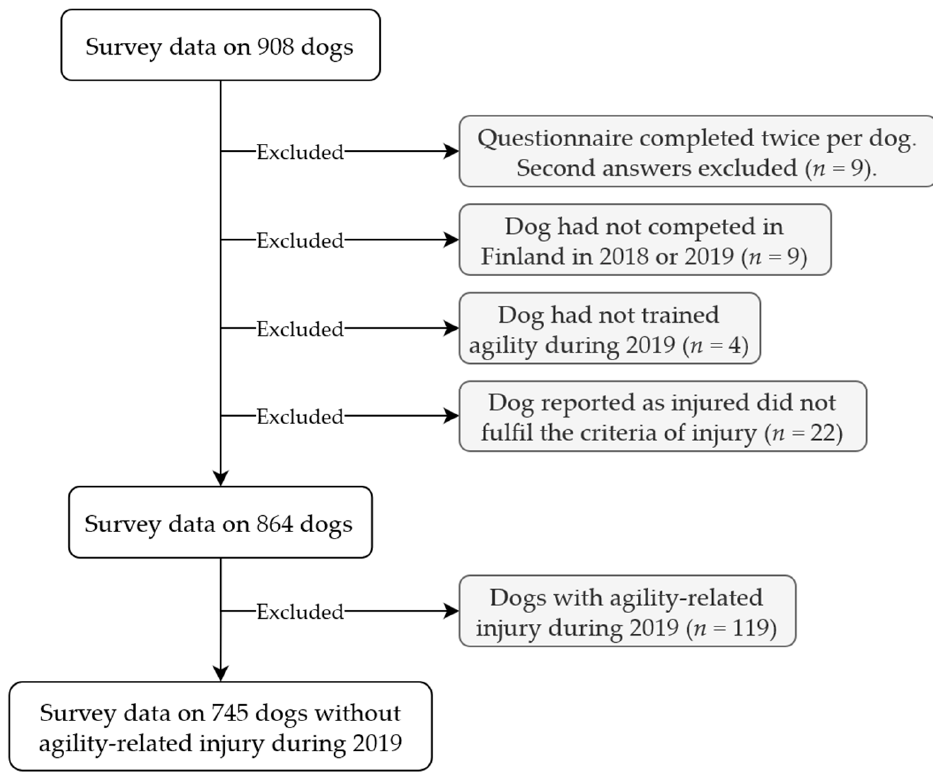
Figure 1. Dogs included in this study.